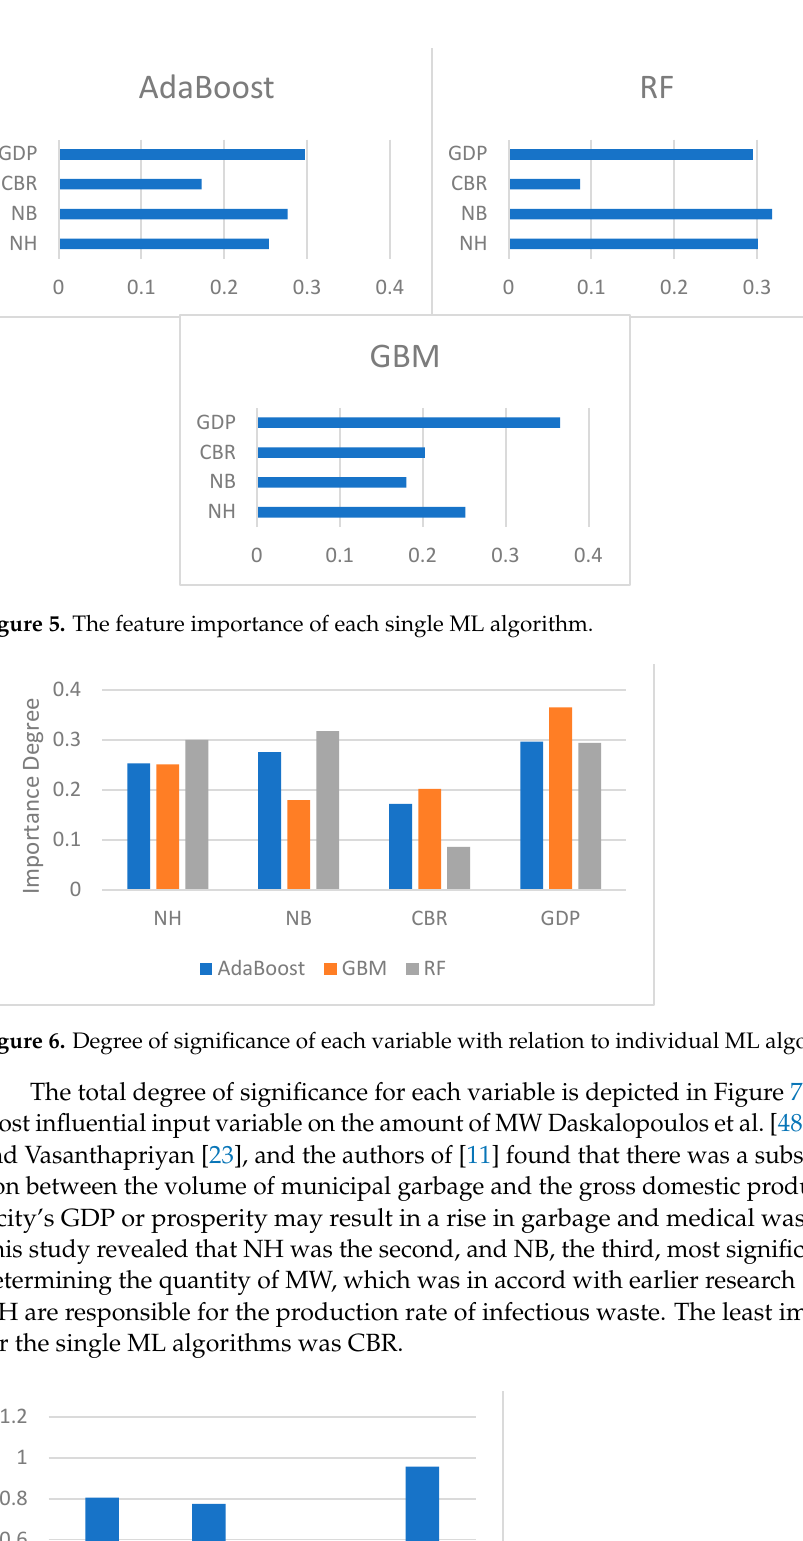
Figure 6. Degree of significance of each variable with relation to individual ML algorithms.